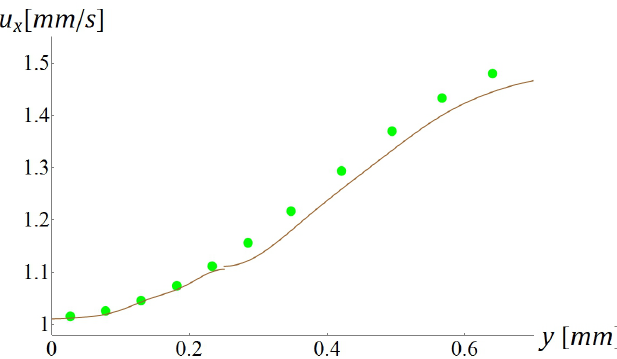
Figure 15. 2D plot of distribution of the (cid:1876) component of net molar velocity over the width of the representative unit at the midway between inlet and outlet (z = 0